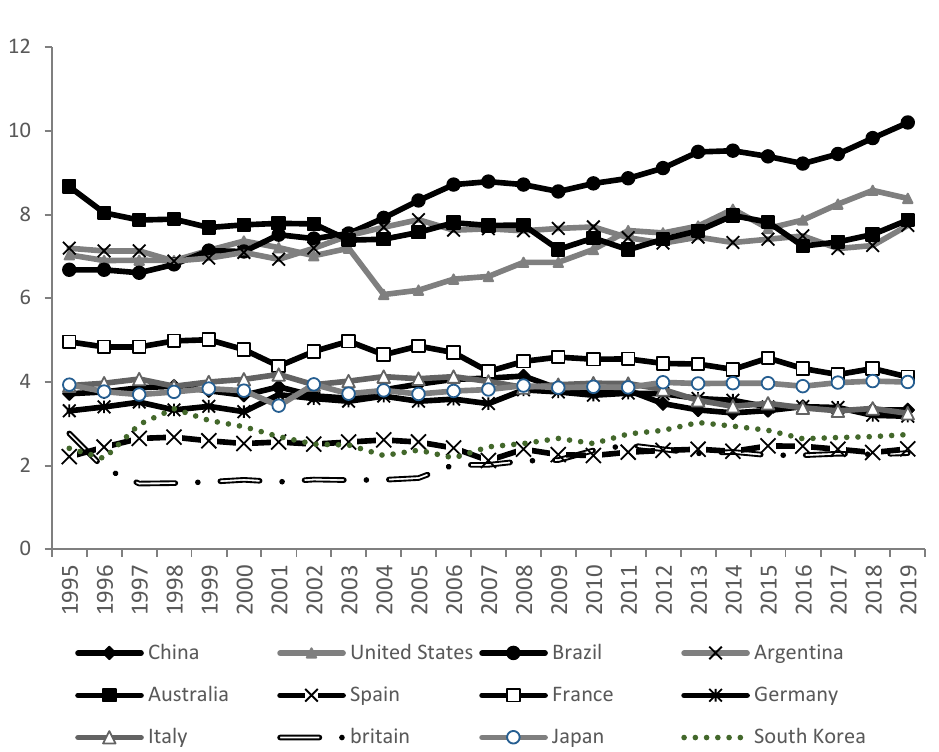
Figure 1. Comparison of the level of development of the beef cattle industry in the representative countries from 1995 to 2019. Table 3. Comparison of the development level of the subsystems in the beef cattle industry among the representative